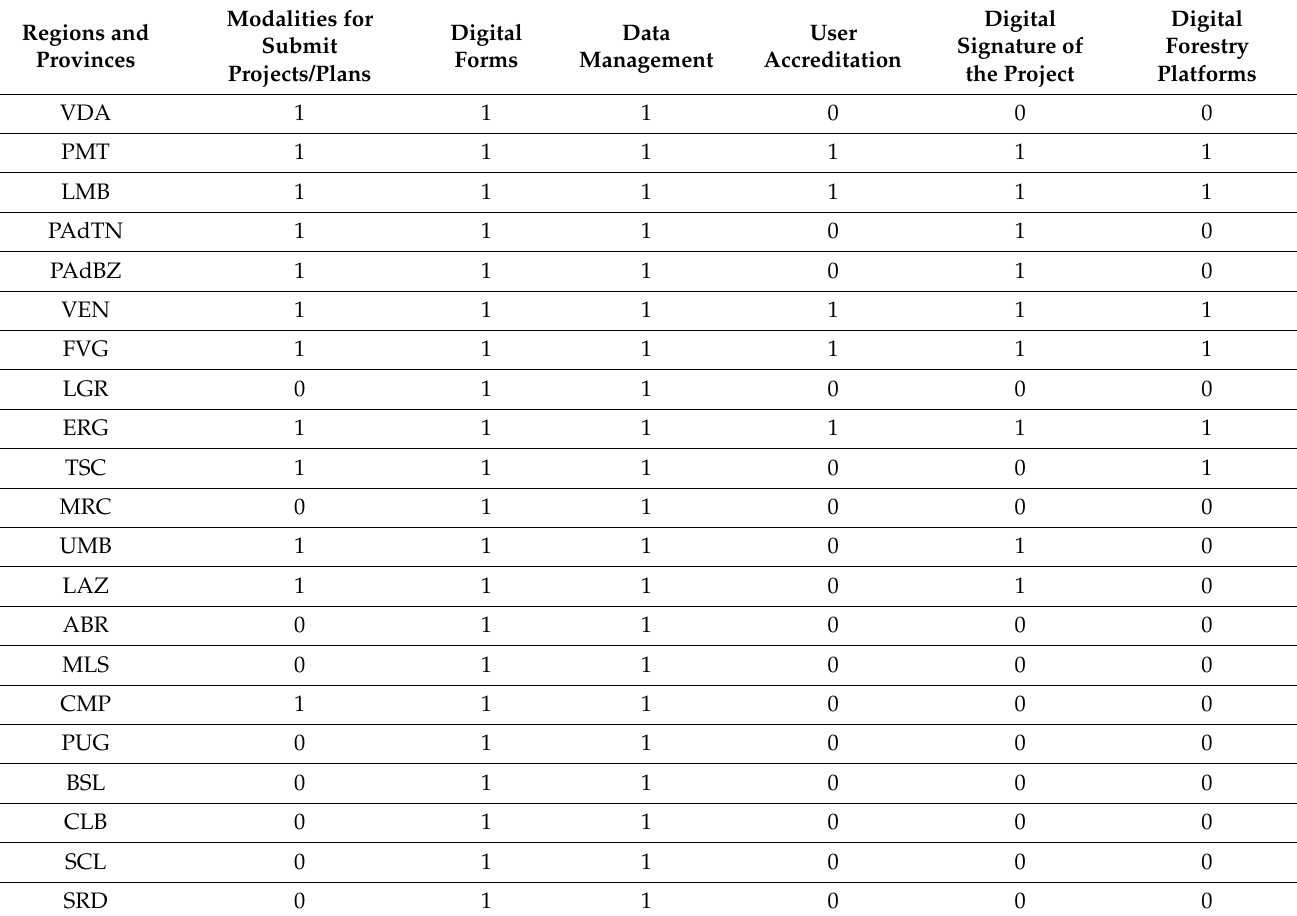
Table 2. Outcomes of the semi-open